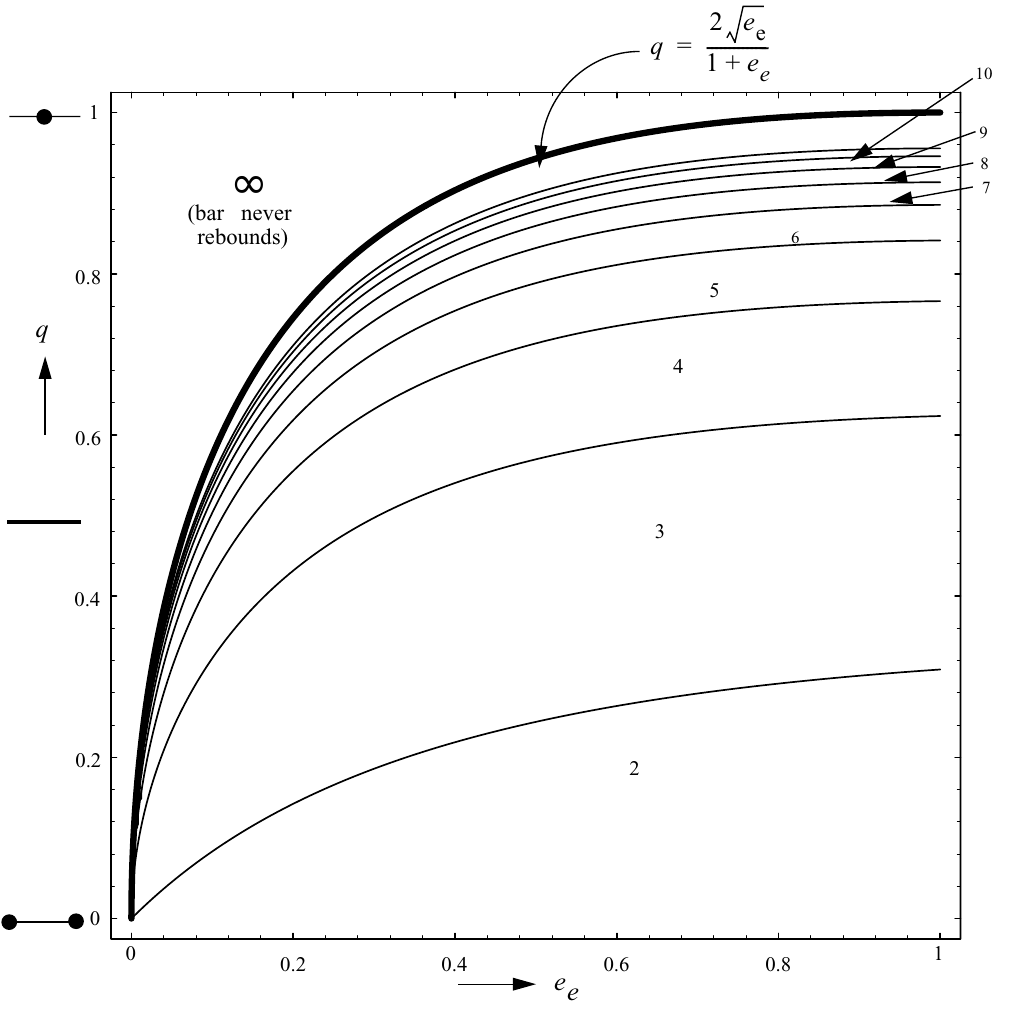
Fig. 2. Contour-plot of the number of impacts in the [ q,e e ] plane. (Mass distributions corresponding to q = 0 , 0 . 5 and 1 are illustrated schematically on the left of the q axis.) The fewest number of impacts occurs for high restitution and high moment of inertia – the minimum is two. The dominant region has 3 impacts, including the most common real-world mass distributions (i.e., small deviations from uniformly √ e e / (1 + e e ) , where the bar experiences an infinite number of distributed mass). There is a significant area outside the bounding curve q = 2 impacts in finite time and never